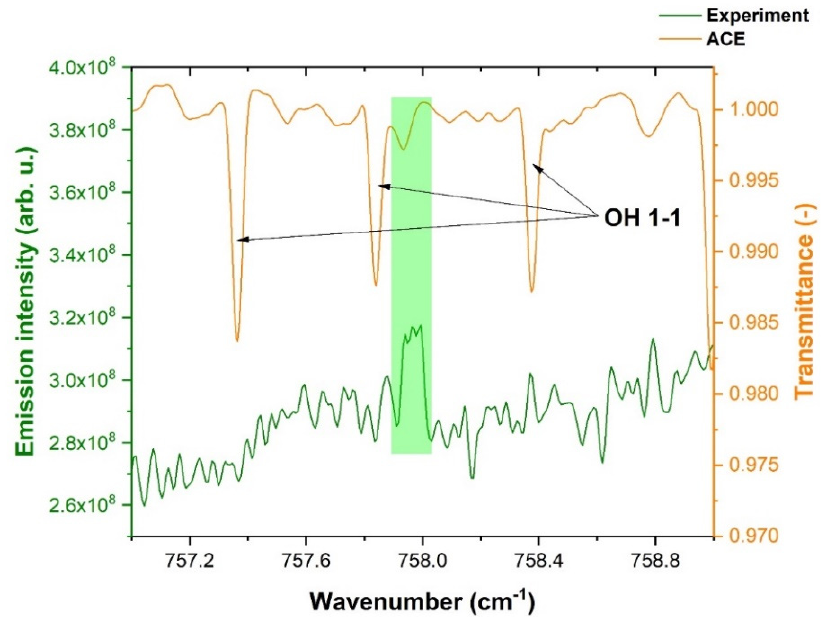
Figure 18. The comparison of ACE solar spectrum with our NH pure rotational triplet [153].